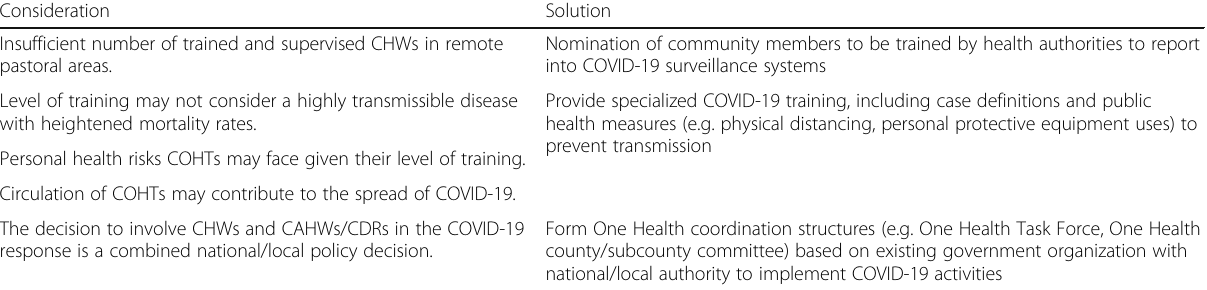
Nomination of community members to be trained by health authorities to report into COVID-19 surveillance systems Provide specialized COVID-19 training, including case definitions and public health measures (e.g. physical distancing, personal protective equipment uses) to prevent transmission